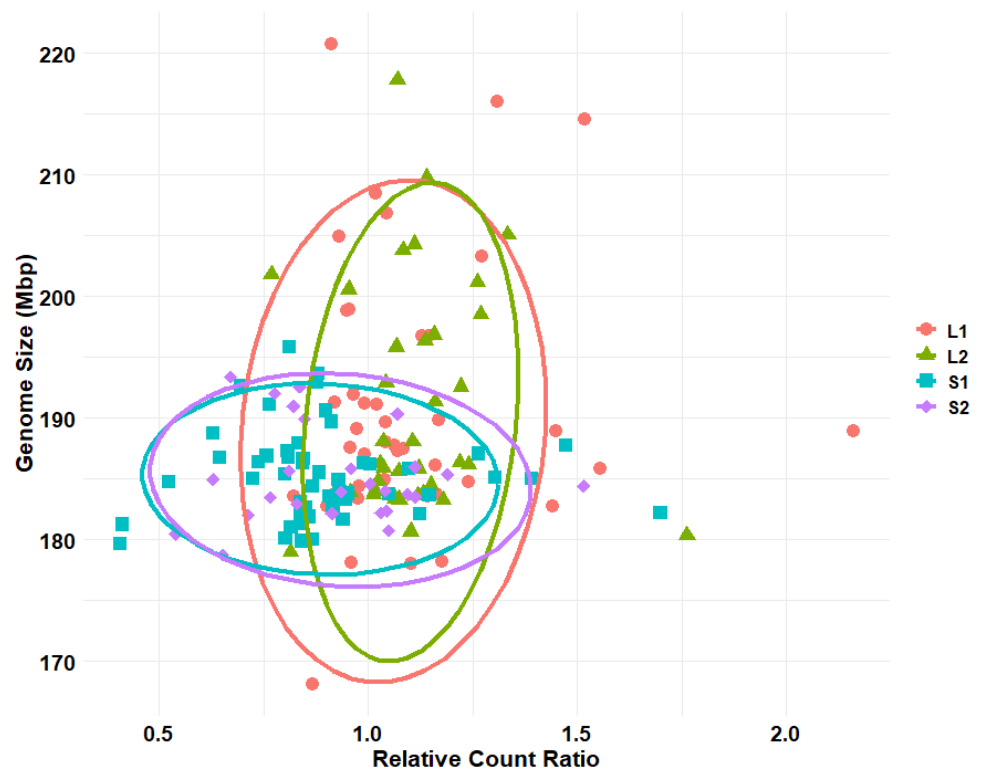
Figure 4. Distribution of genome sizes and relative cell-count ratio for large and small body size selected lines of D. melanogaster . Relative cell-count ratio ( X -axis) plotted against genome size in Mbp ( Y -axis) for large and small body size selected isolines. Large body size selected lines are represented in red circles (L1) and green triangles (L2), small body size lines represented in blue squares (S1) and purple diamonds (S2). Ellipses represent 95% confidence ellipses determined using the stat_ellipse() function in the ggplot2 package of R. Only a subset of large body size selected D. melanogaster isolines showed an increase in genome size. A two-dimensional Kolmogorov-Smirnov test using the function peacock2() in the package ‘Peacock.test’ found the distributions of large and small body size flies to be significantly different ( p < 0.001) [41] .